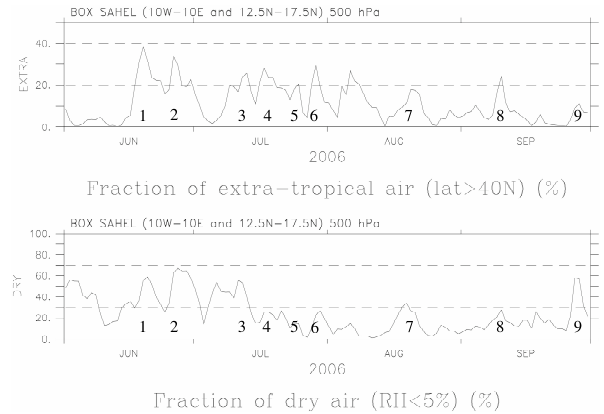
Figure 21. Top: Time series of the fraction of extra-tropical air over the 10°W-10°E 12.5°N- 17.5°N Sahelian box at 500 hPa. Bottom: Time series of the fraction of dry air (RH < 5%) at 500 hPa over the same box. See text for details.